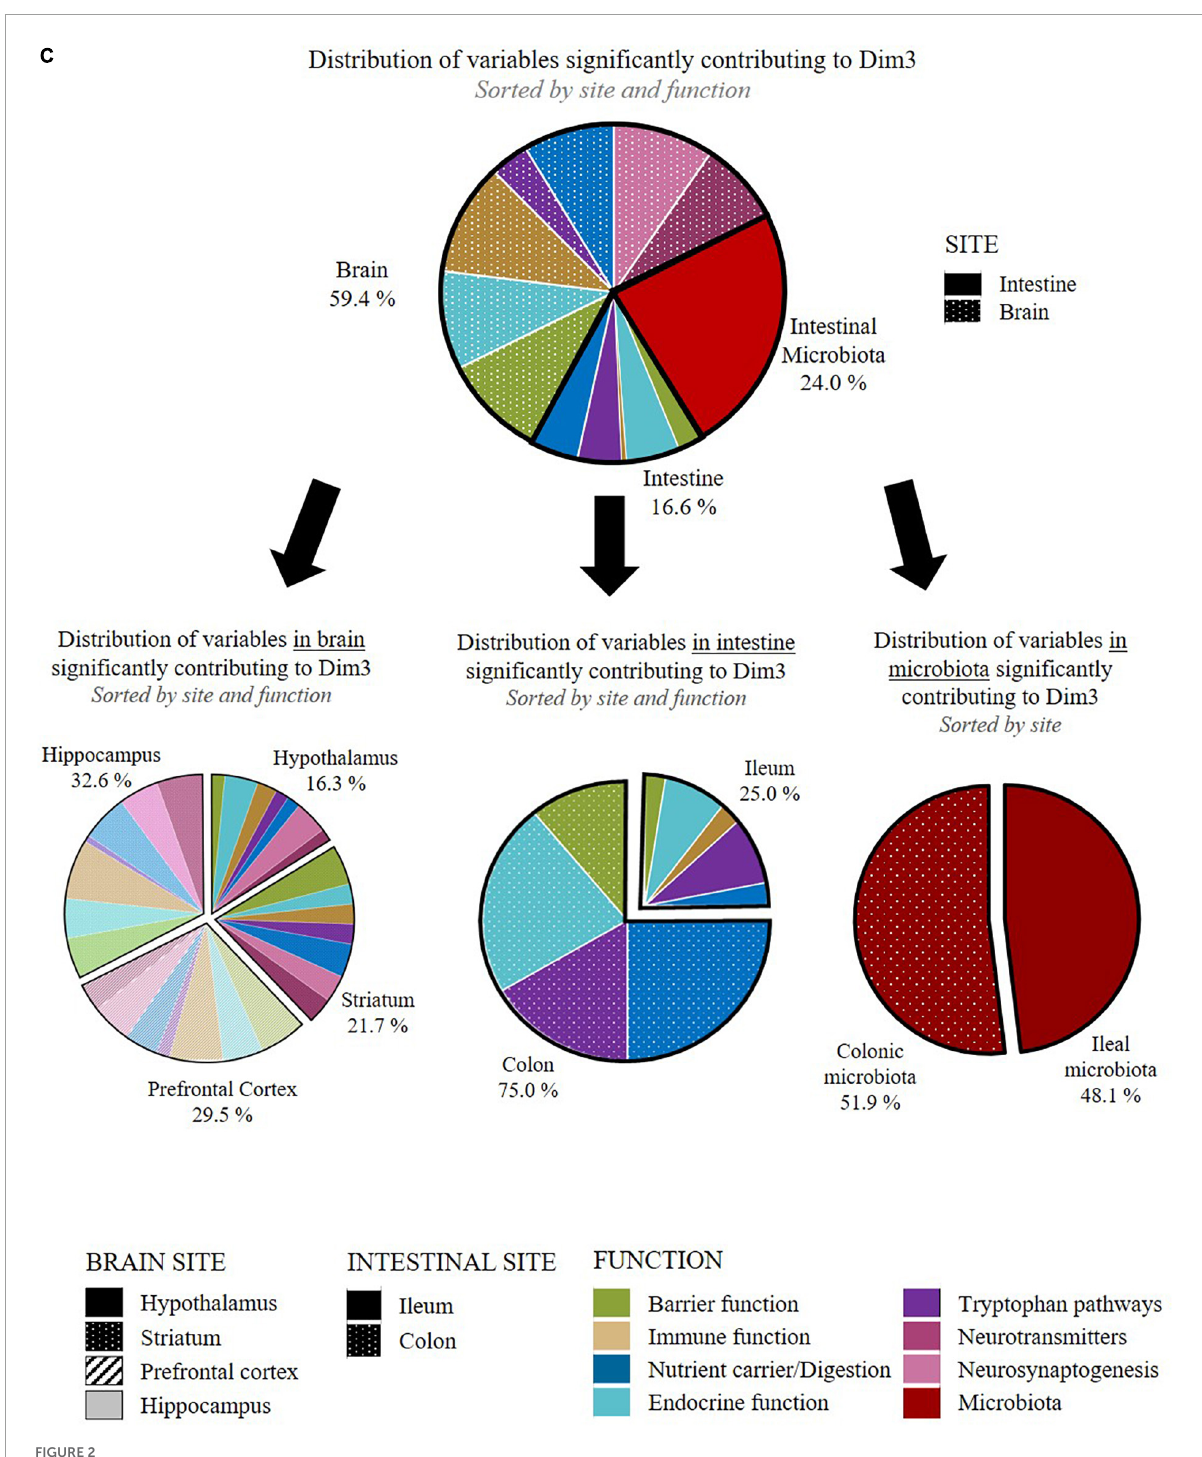
FIGURE2 ( A) Multiple factor analysis using microbiota, intestinal and brain variables analyzed in HM- and IF-fed piglets and grouped by site and function or phylum ( n = 19 groups of variables). Red dot line: level of statistical significance corresponding to the inverse of the number of variable groups used in the analysis. (B) Distribution of variables contributing to Dim1 of the MFA as a percentage of variables which contribute for more than 0.141%. Selection criteria of 0.141% was calculated by dividing a base 100 by the total number of variables included in the MFA (n variables total = 709) and expressed as a percentage. PFC, prefrontal cortex. (C) Distribution of variables contributing to Dim3 of the MFA as a percentage of variables which contribute for more than 0.141%. Selection criteria of 0.141% was calculated by dividing a base 100 by the total number of variables included in the MFA ( n variables total = 709) and expressed as a